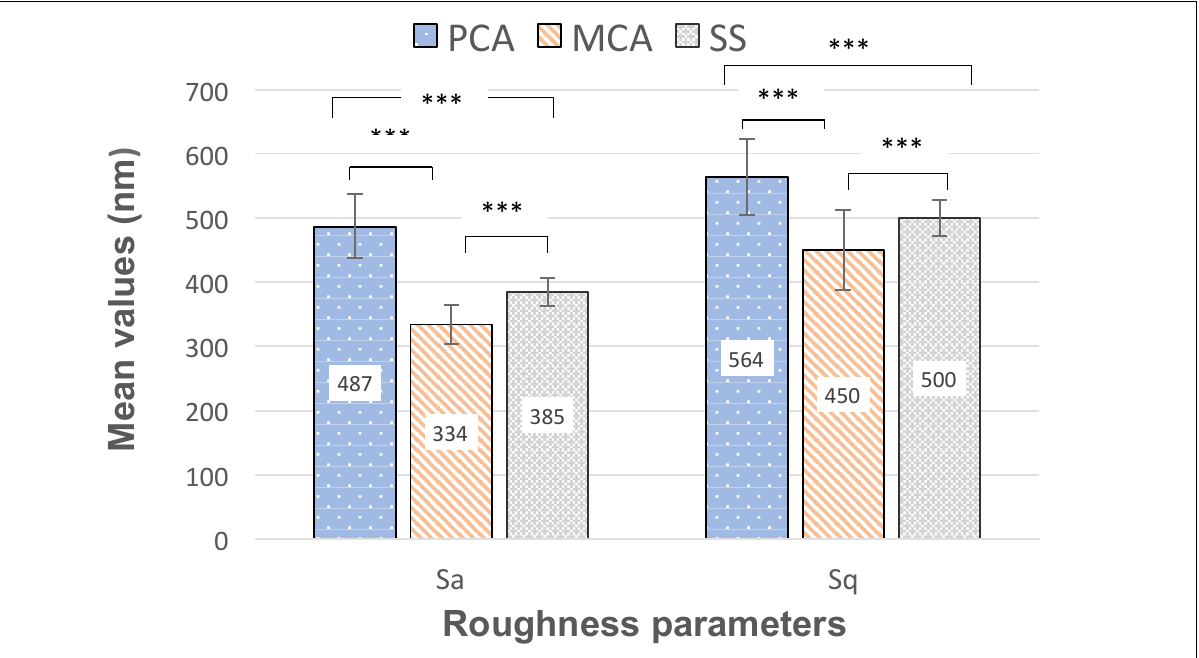
Figure 6. Bar graph comparing average roughness (Sa) and root mean square (Sq) among bracket groups. *** p ˂ 0.001